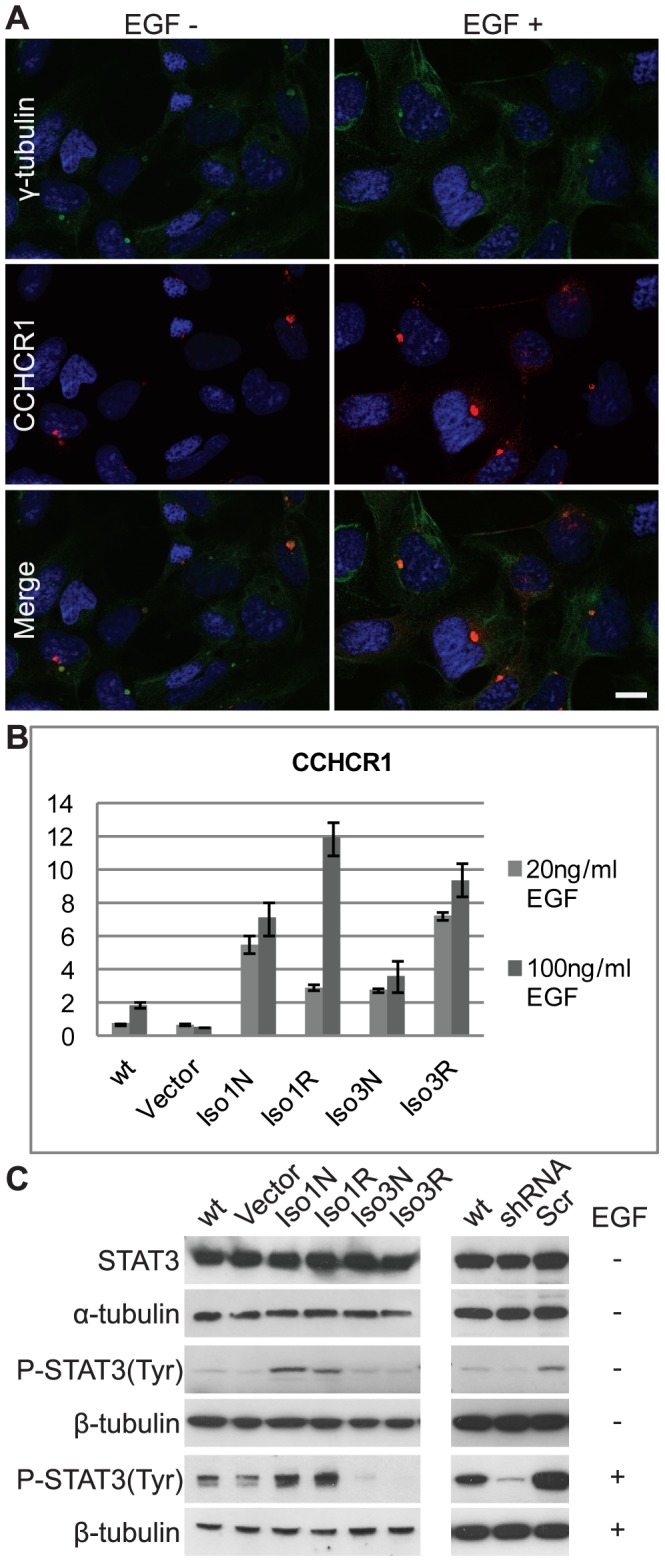
CCHCR1 and EGFR-STAT3 signaling.The localization and expression of CCHCR1 is altered after the stimulation of stable cell lines with EGF as shown by (A) immunofluorescence staining and (B) qPCR. (A) After EGF treatment cytoplasmic CCHCR1 (red) expression is increased though some protein still co-localizes with γ-tubulin (green), thus remains at the centrosome. All isoforms respond similarly to EGF (EGF+), in panel (A) Iso1Non-risk cells are shown. Also on RNA level (B), when compared with non-treated cells (EGF-), all EGF-treated cell lines show upregulation of CCHCR. Error bars represent SD. Following the EGF treatment (100 ng/ml 18 h) in stably transfected cells, CCHCR1 overexpression has an isoform-specific effect on the STAT3 activation. As shown by Western Blotting (C), the EGF-induced Tyrosine 705 phosphorylation of STAT3 is disturbed in both isoform 3-expressing cell lines (Iso3Non-risk (Iso3N) and Iso3Risk (Iso3R)), whereas isoform 1 cells (Iso1Non-risk (Iso1N) and Iso1Risk (Iso1R)) show similar STAT3 phosphorylation as wild type cells (wt). The Iso1Non-risk and in some extent also Iso1Risk cells are able to induce tyrosine 750 phosphorylation without any EGF treatment. The silencing of CCHCR1 in HEK293 cells (shRNA) reduces tyrosine 750 phosphorylation when compared with the control cell line transfected with the scrambled sequence (Scr) or to wild type cells. Overexpression or silencing of CCHCR1 does not affect the expression level of STAT3. Staining with the antibody for β-tubulin was used to control sample loading on SDS-PAGEs. Scale bar 10 µm.